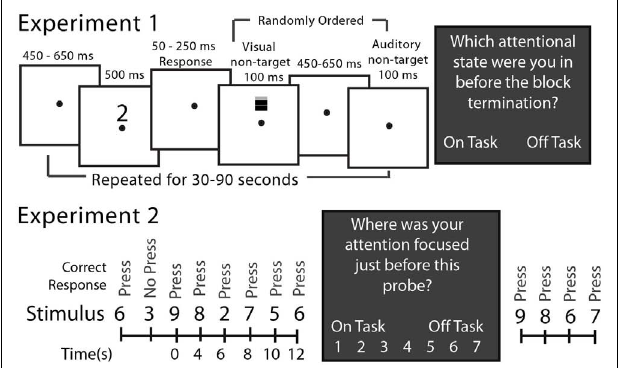
FIGURE 1 |The SART for Experiments 1 and 2. In Experiment 1 at the top, open boxes illustrate video screen frames in the sequence presented to the subject.The target stimuli requiring responses were the randomly selected numerals 0–9 and the no-response target was an “X.” Non-target stimuli, which were never responded to, were either a grating presented on the screen above the fixation point or a brief sound.These occurred on every trial but in random order from trial to trial. In Experiment 2 at the bottom, only the sequence of stimuli is illustrated there.The target stimuli requiring responses were the numerals 0–2 and 4–9 and the no-response stimulus was a “3”; there were no non-target stimuli.The dark boxes illustrate the experience (attention state) probes that interrupted the ongoing SART from time to time, and which were different in the two